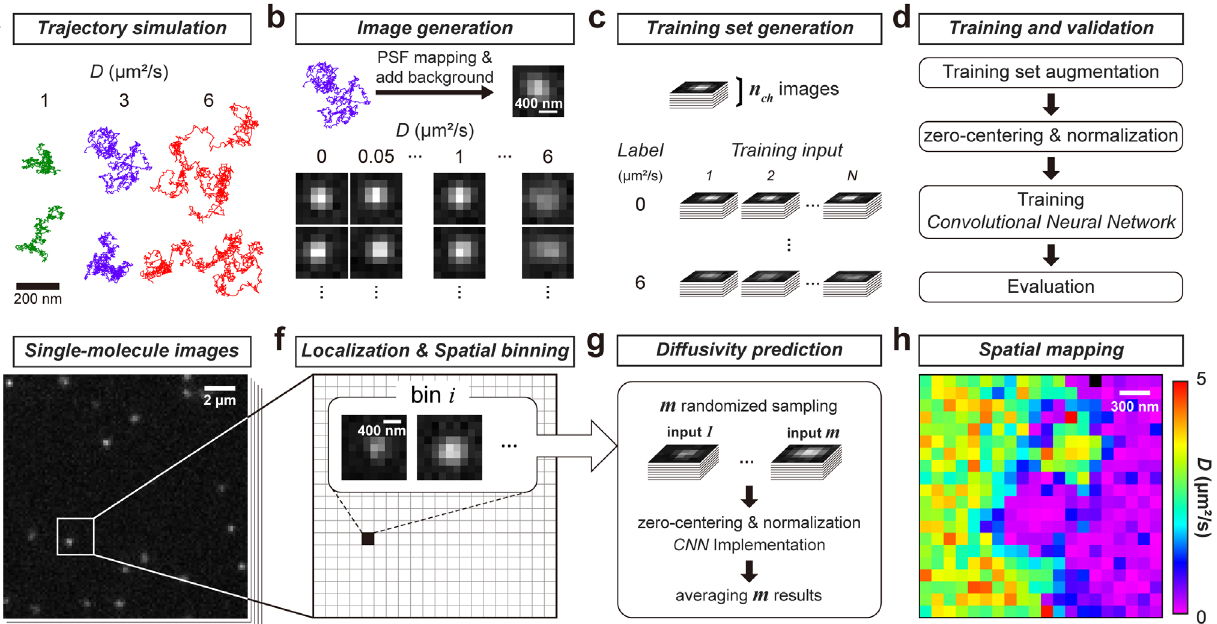
Fig. 1 Pix2D CNN training and implementation. a Examples of simulated Brownian trajectories for D = 1, 3, and 5 µ m 2 /s for a camera exposure time of 9 ms. b Mapping of simulated trajectories to pixelized images using the microscope point spread function pro fi le and a pixel size of 160 nm. 400 independent trajectories were initially generated for every D -value in the range of 0 – 6 µ m 2 /s at a 0.05 µ m 2 /s spacing. c As CNN training input, for each D label, hundreds of stacks of n ch simulated images, each sampled as 7 × 7 pixels, were initially selected per diffusivity label. d The training data were then augmented via domain randomization, in which multiple image sets were created through identical processes as in a – c , but with different combinations of noise levels and photon counts. The CNN model was then trained with the augmented data. e – h Implementation of Pix2D diffusivity spatial mapping. Single-molecule signals from the raw image sequence were localized and spatially binned with a fi xed grid size ( f is a zoom-in of the boxed region in e ). g For each bin, m = 100 permutations of n ch single-molecule images were each fed to the trained model. The resultant m predicted D- values were averaged to give the diffusivity of the bin. h The results of different spatial bins were color-coded to generate a spatial